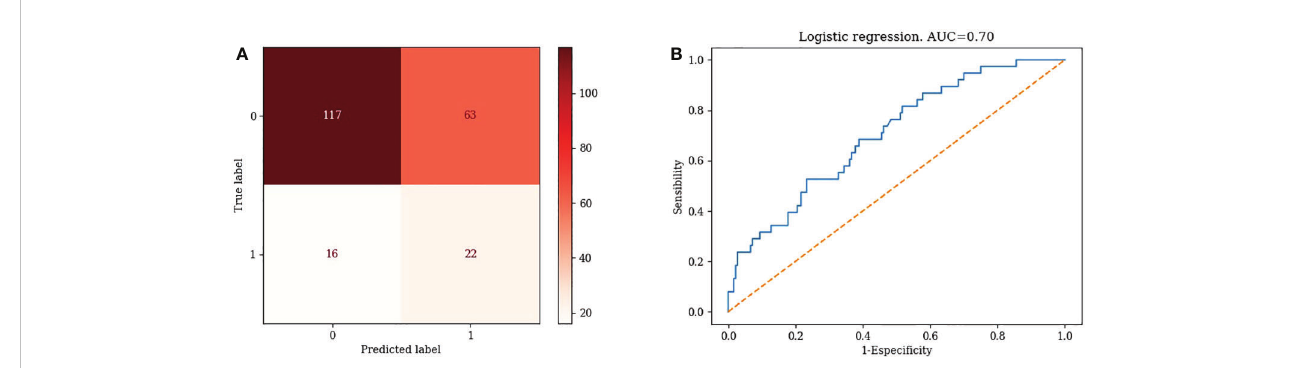
FIGURE 2 Confusion matrix and ROC curve of Logistic Regression algorithm.